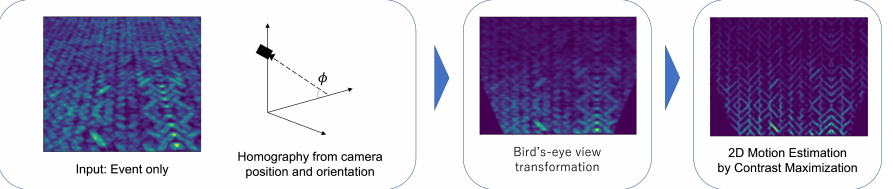
Figure 3. System flow. The input is only events. The events are transformed into a bird’s-eye view using the homography computed from the camera position and angle. The 2D motion estimation is then performed using contrast